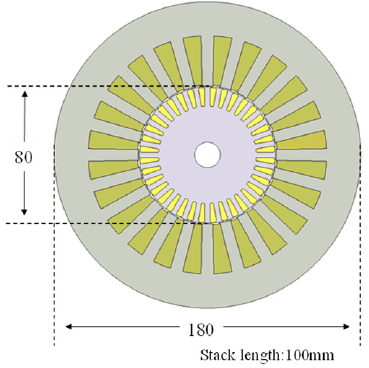
Figure 15. Dimension of designed IM.